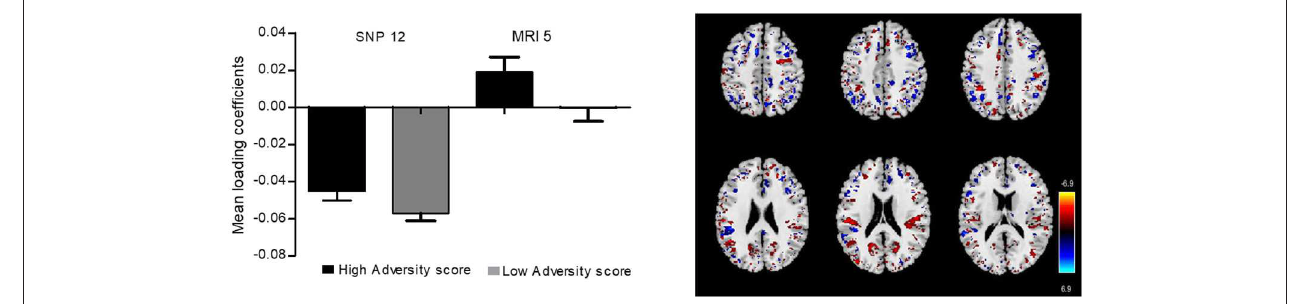
FIGURE 9 | A bar plot of the mean loading coefficients of brain magnetic resonance imaging (MRI) component and genetic component. Student’s t -test was performed to compare loading coefficients means between groups of high and low adversity score for SNPs (single nucleotide polymorphisms) and MRI.